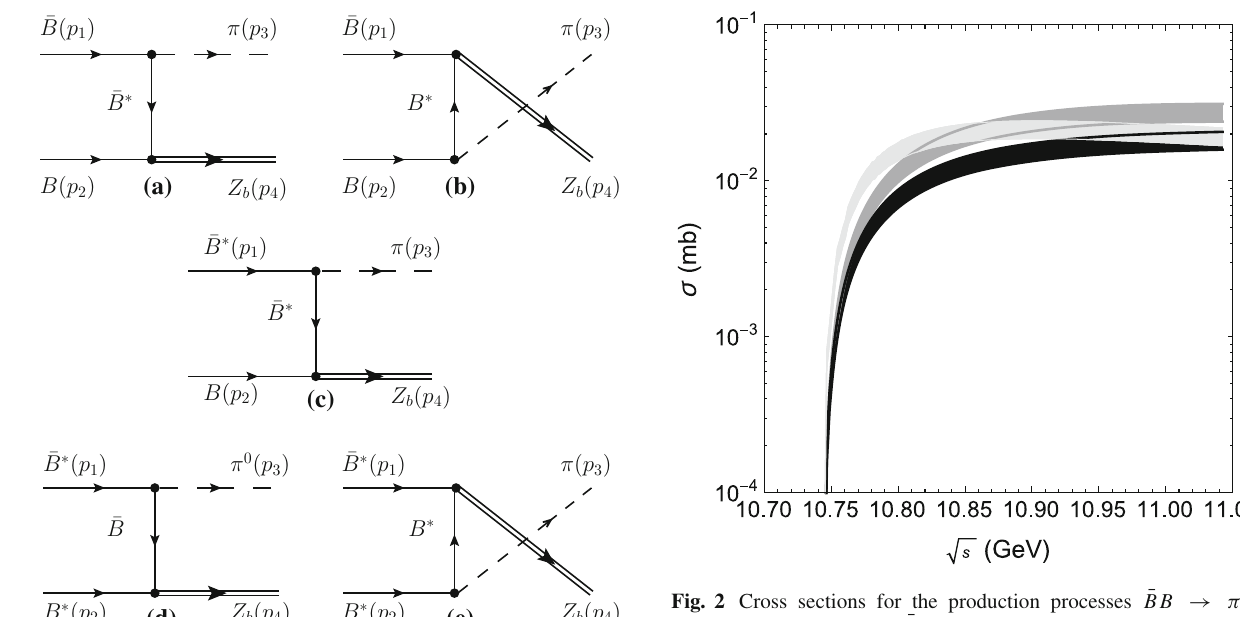
Fig. 2 Cross sections for the production processes ¯ BB → π Z b (medium shaded region), ¯ B ∗ B → π Z b (dark shaded region) and ¯ B ∗ B ∗ → π Z b (light shaded region), as function of CM energy m B = 5279 . 4 MeV; m B ∗ = 5324 . 8 MeV; m = 10609 MeV; m Z 0 b